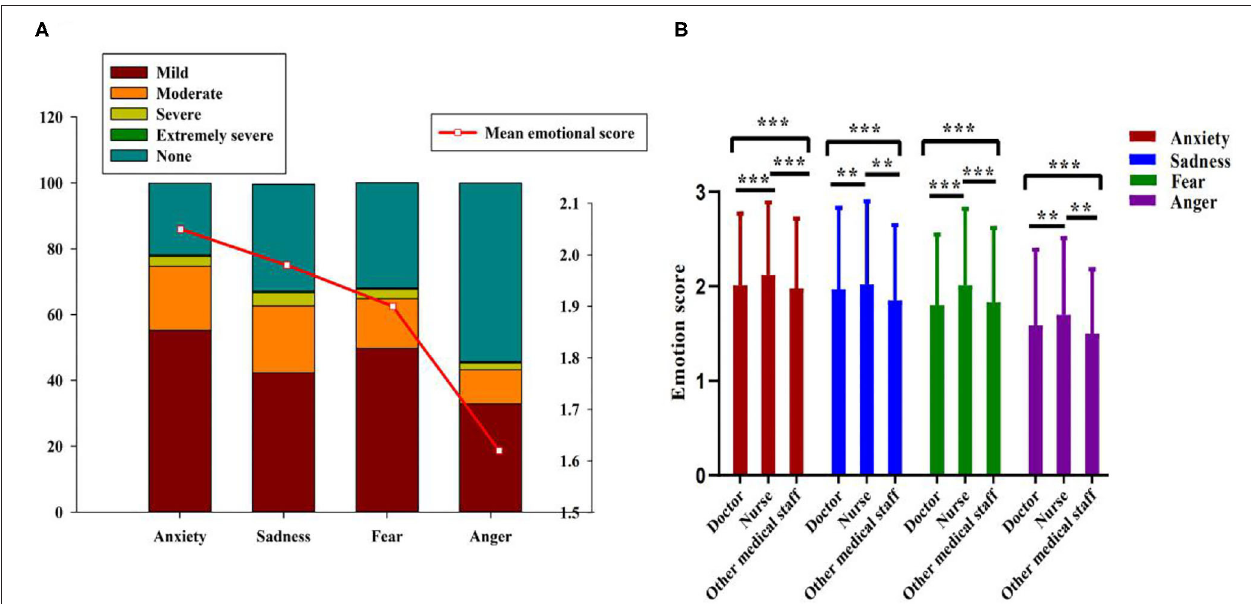
FIGURE 1 | The negative emotional levels of different medical staff. (A) The overall negative emotional levels and response rates. (B) The negative emotional levels between different professionals. ** p < 0.01, *** p < 0.001.